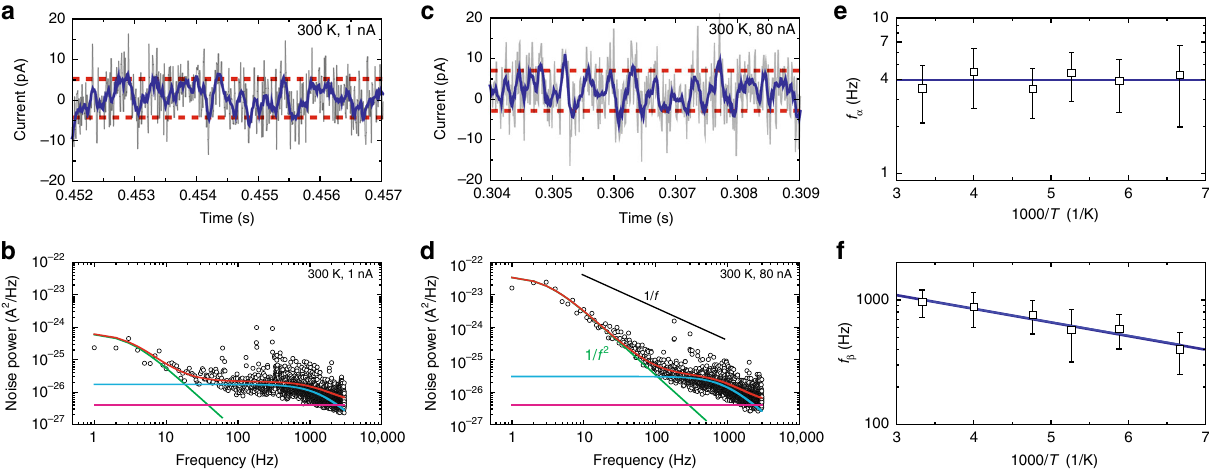
Fig. 3 LF noise – current data and associated spectra. a Noise signal current trace ( I ac = I − I bias , for I bias = 1 nA) acquired at room temperature (gray line); low-pass fi ltered current trace (blue line). The current trace exhibits switching between multiple discrete levels involving a small number of vacancy defects (red lines highlight the extremes of switching). As low-pass fi lter, we use a Savitzky-Golay fi lter of polynomial order 3. b Noise power spectrum S I ( f ) corresponding to the data set in a . c , d Corresponding data acquired on the same sample at I = 80 nA. Measured spectra are well described by Eq. bias (1), comprising two Lorentzian functions of widths f α = 4 Hz (green line) and f β = 1 kHz (cyan line). In contrast, spectra are inconsistent with 1/ f behavior expected for fl icker noise (black line). Measurement sensitivity limit is set by instrument noise (violet line). e , f Temperature dependence of characteristic frequencies, ( e ) f α , and ( f ) f β , in coordinates log( f ) vs. 1000/ T . Via Eq. (2), the fi tted slopes (blue lines) allow us to evaluate the kinetic barriers associated with switching processes. We observe no temperature dependence of f α , establishing an upper limit of E α < 15 meV for the process V S ( − 1) ↔ V S ( − 2). For f β , we obtain the kinetic barrier E β = 23 meV for the process V S (0) ↔ V S ( − 1). Error bars, standard